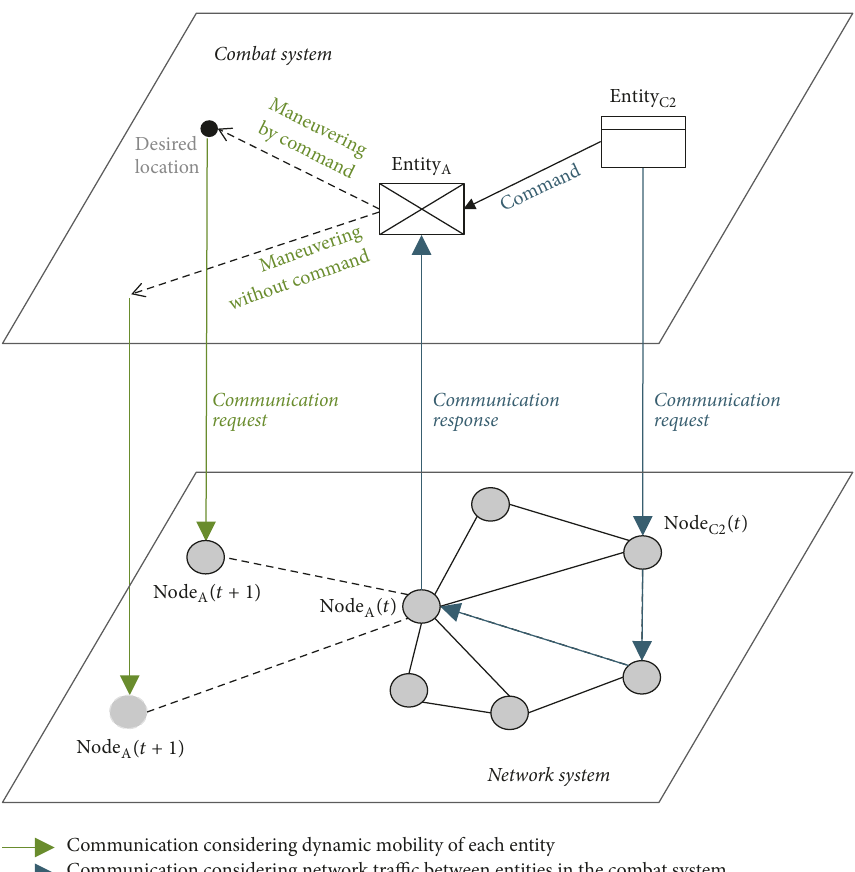
Figure 2: Traffic and mobility data exchanged between the combat system and the network